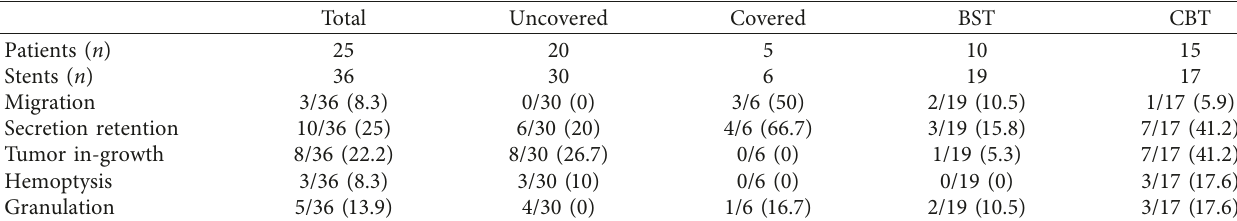
Table 3: Stent-related complications in 30days after stents placement. Total